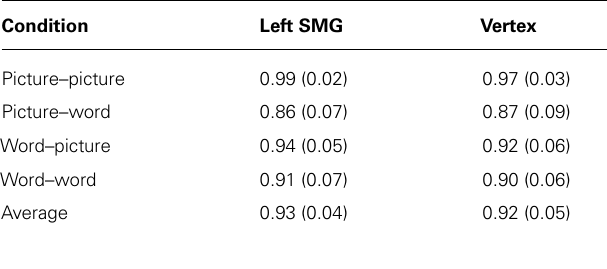
Table 1 | Mean accuracy (and standard deviation) for each task condition and each rTMS